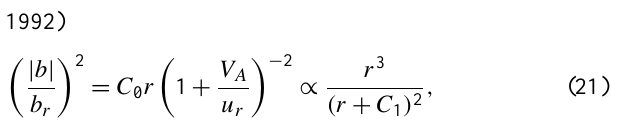
Fig. 7. The Elsasser variables z 0 p = u 0 y − b 0 y / √ ρ (black dashed line) at t = 22 . 0 in (a) Run A, and z 0 m = u 0 y + b 0 y / (b) Run B, and (c) Run